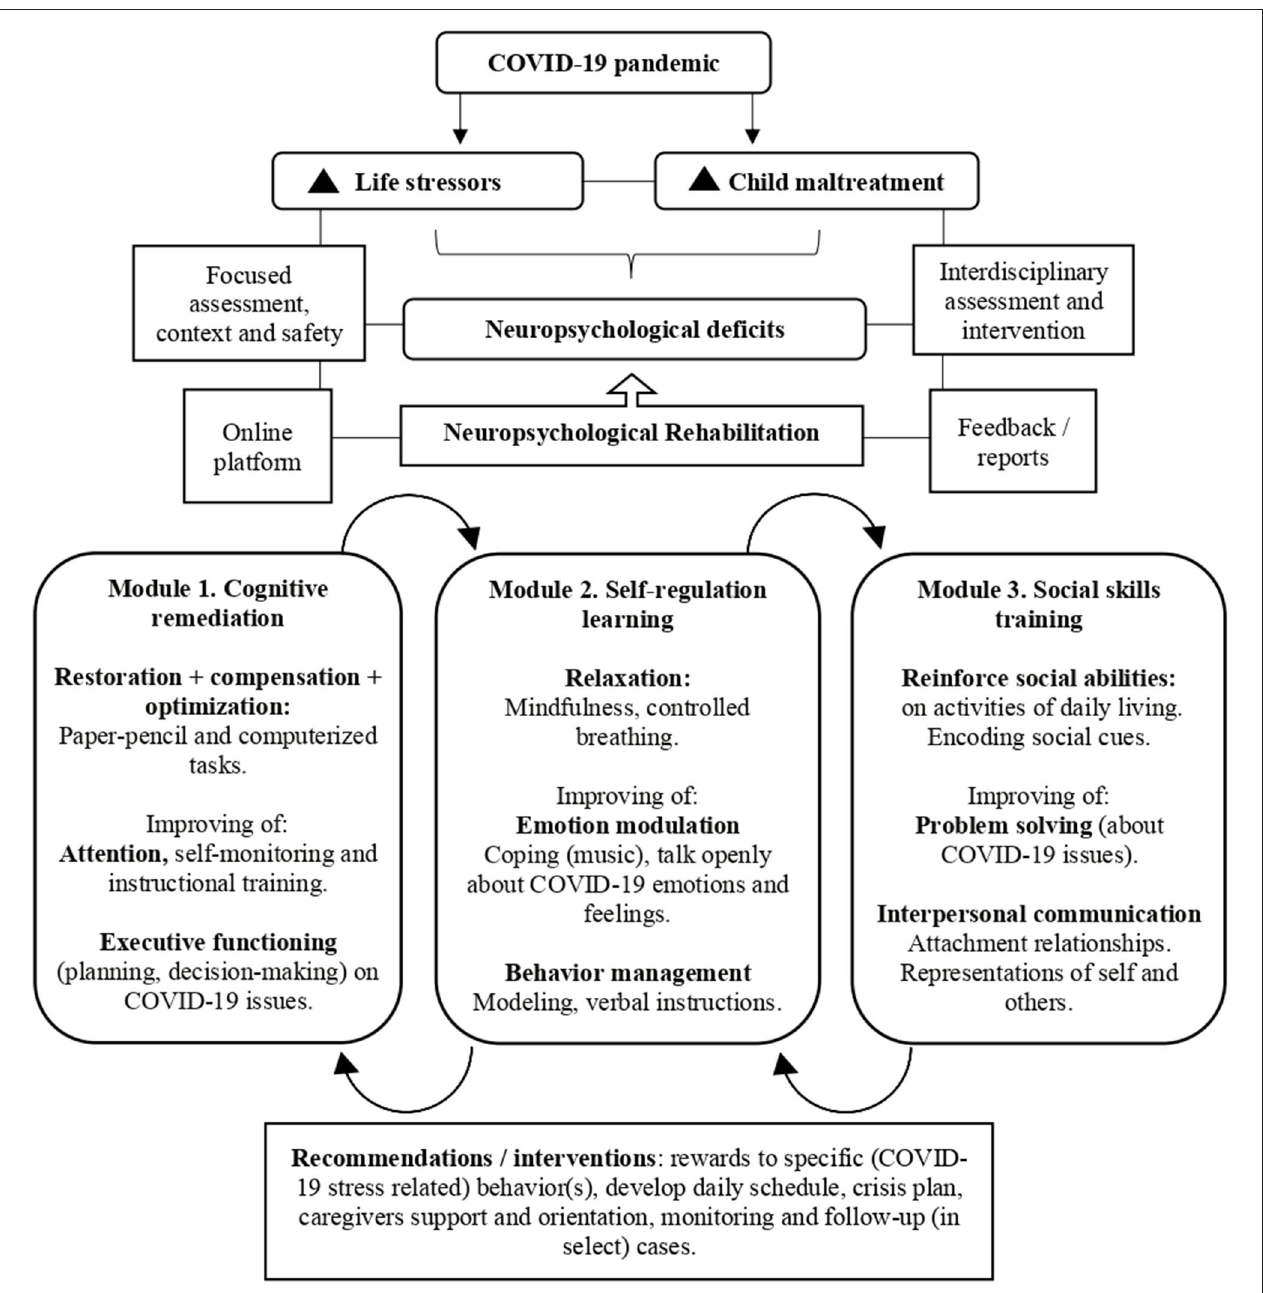
FIGURE 1 | Principles and activity modules of the neuropsychological rehabilitation program for children affected by maltreatment in the context of COVID-19